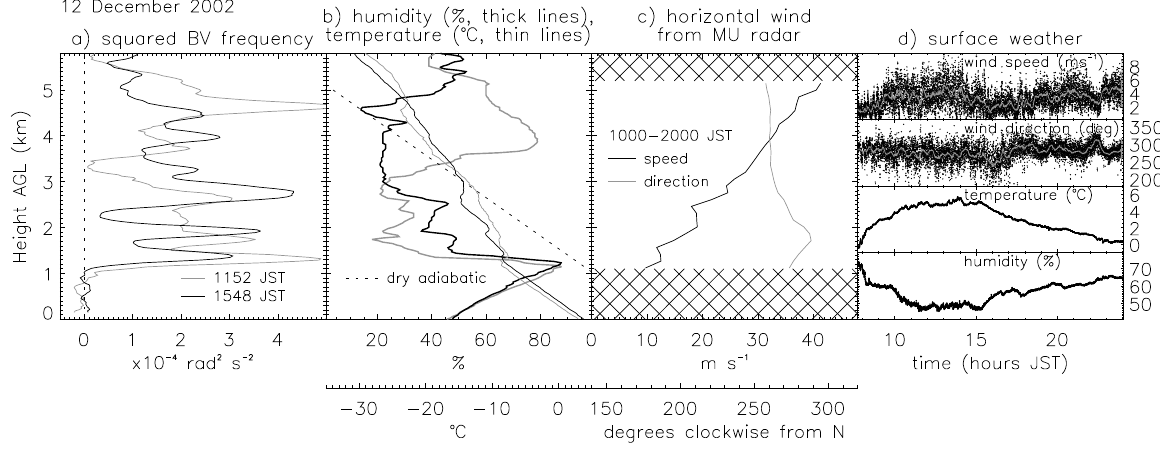
Fig. 3. ( a ) squared Brunt-V¨ais¨al¨a frequency, ( b ) relative humidity and temperature from radiosondes launched 1152 and 1548 JST at the MU radar site; ( c ) horizontal wind speed and direction measured 1000–2000 JST, ∼ 1–5km AGL, by the MU radar; ( d ) surface weather at the MU radar site; dots are 5-s time averages, with a 10-min running median overplotted of horizontal wind speed and direction.